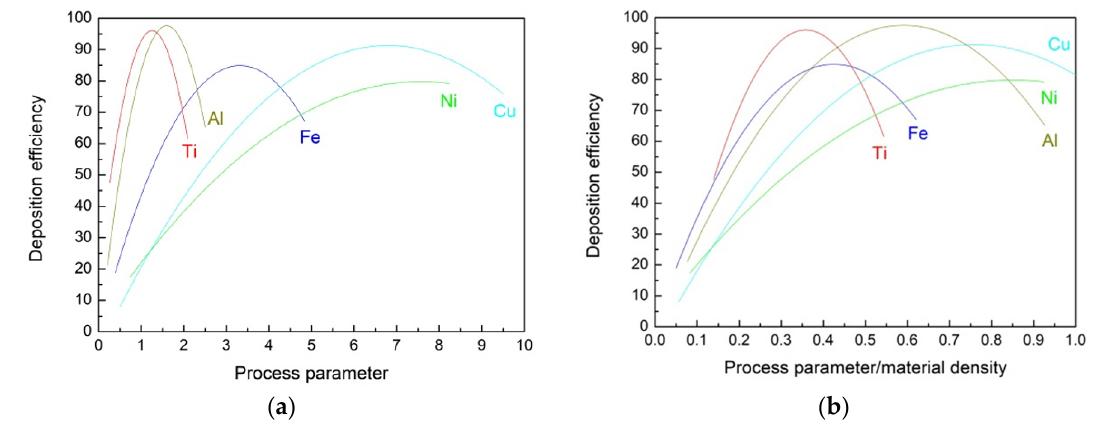
Figure 6. Deposition efficiency as a function of ( a ) the process parameter and ( b ) the process parameter normalized to the material density.